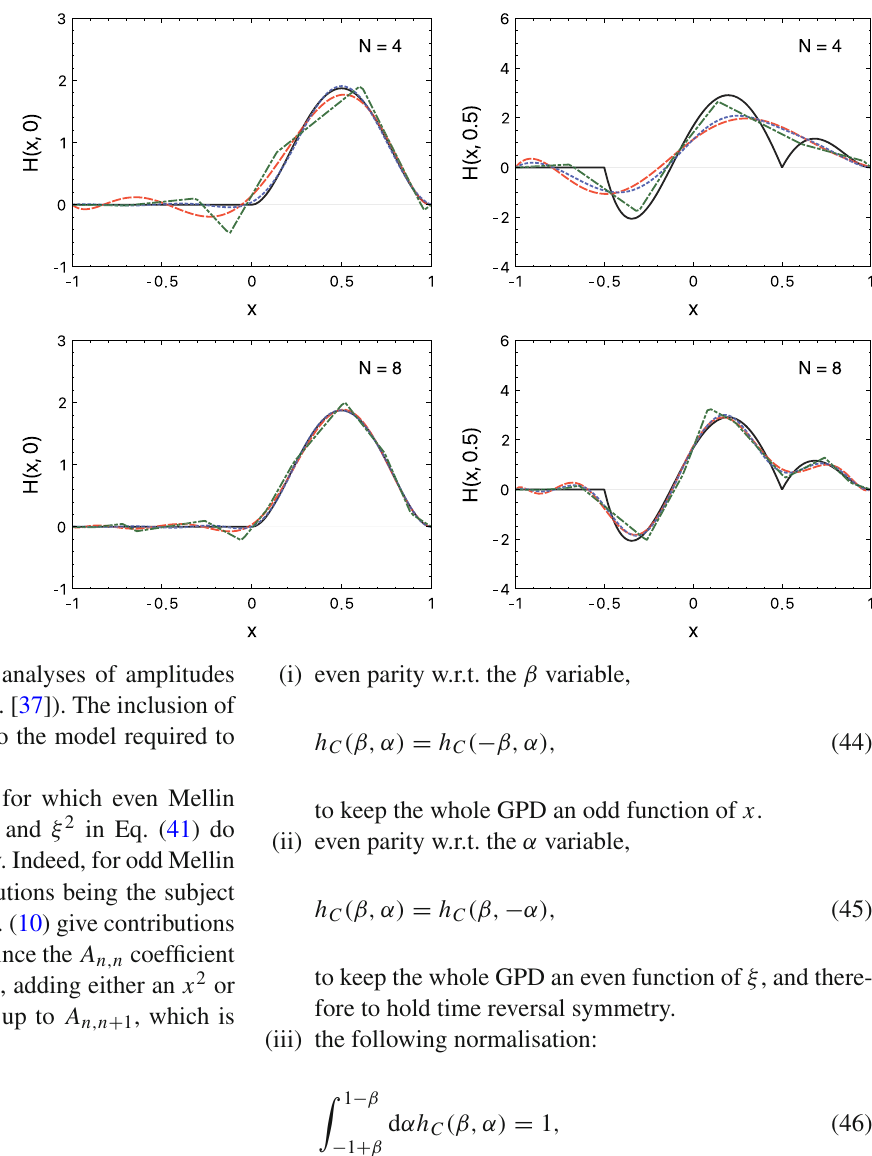
Fig. 3 The pion model [59,60] (black solid line) given by Eq. (37) reconstructed from either five ( N = 4, top row) or nine ( N = 8, bottom row) of its first Mellin moments as a function of x for either ξ = 0 (left column) or ξ = 0 . 5 (right column). The reconstruction is done using a polynomial basis (red dashed line) or an ANN basis with either sigmoid activation function (blue dotted line) or ReLU activation function (green dash-dotted